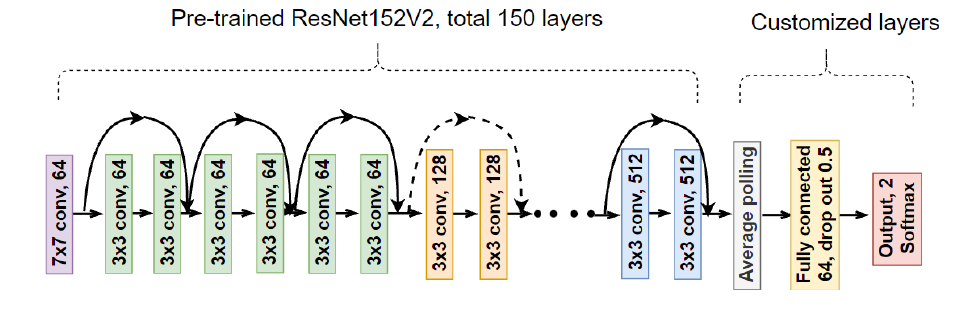
Fig. 9 Architecture of customized ResNet152V2 model